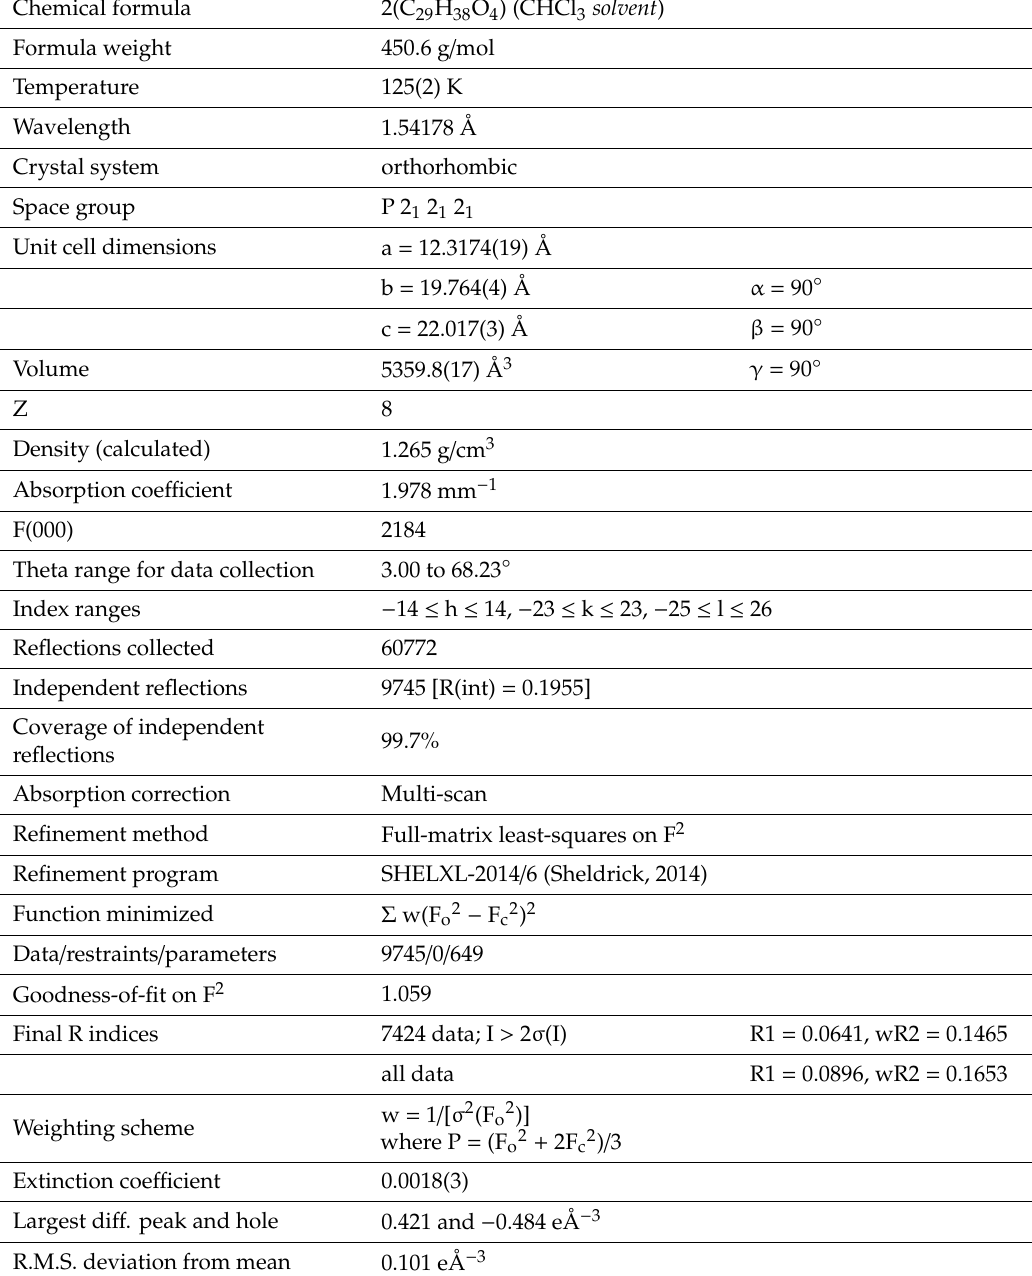
Table 1. Crystal data for